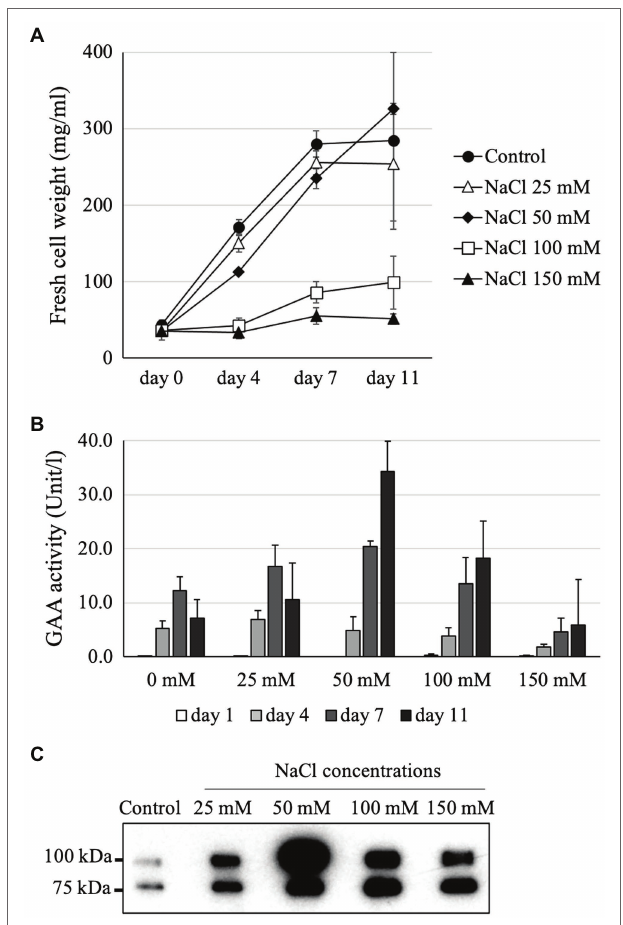
FIGURE 4 | Optimization of the NaCl concentration for yielding the highest GAA production while maintaining Arabidopsis alg3 cell growth. (A) Effects of addition of 0–150 mM NaCl on the cell growth of a GAA-producing Arabidopsis alg3 cell culture. Data are average of three independent replications. (B,C) Evaluation of GAA accumulation in the NaCl-supplemented culture medium by GAA activity assay and Western blot, respectively. The media of 11-day-old cultures are used for the Western blot.